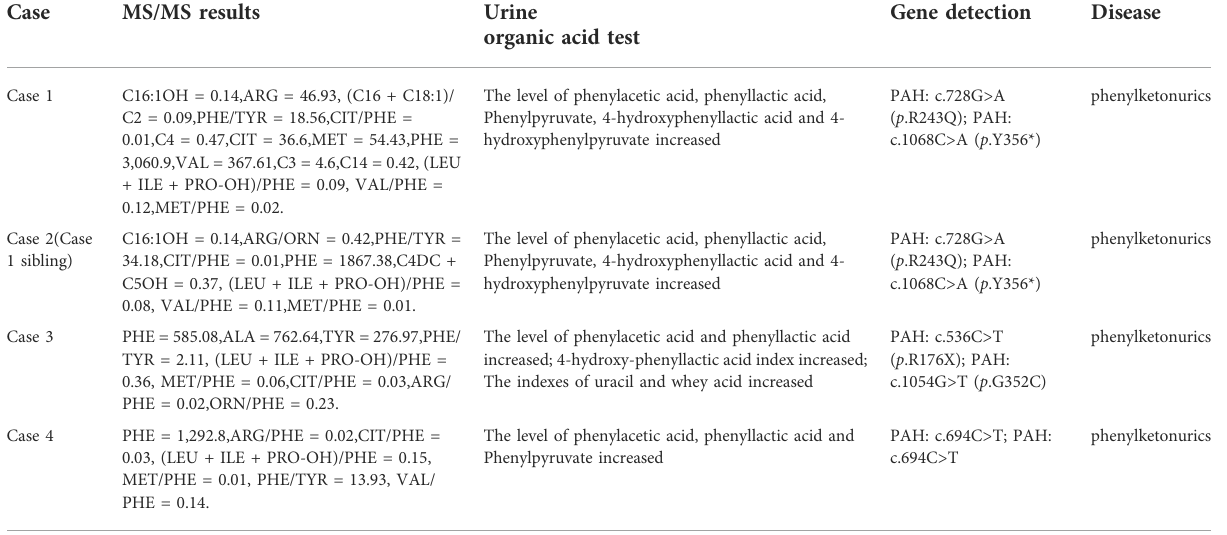
TABLE 4 Diagnosed cases in neonatal screening in